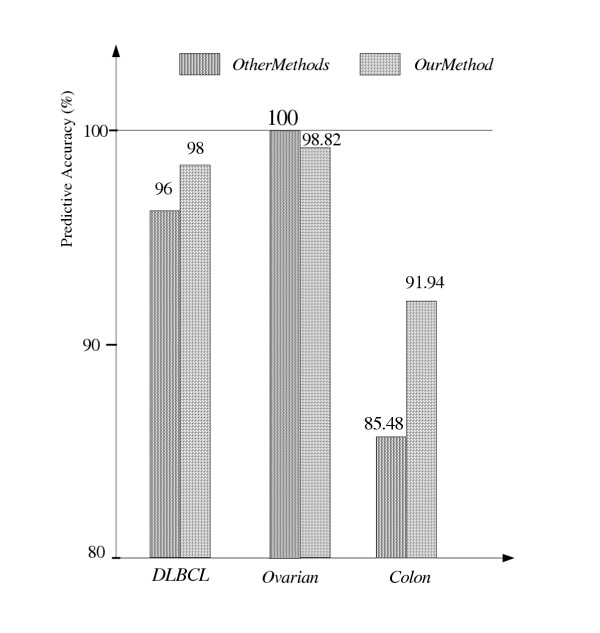
Comparing predictive accuracy of 3 datasets without testing samples with other methods